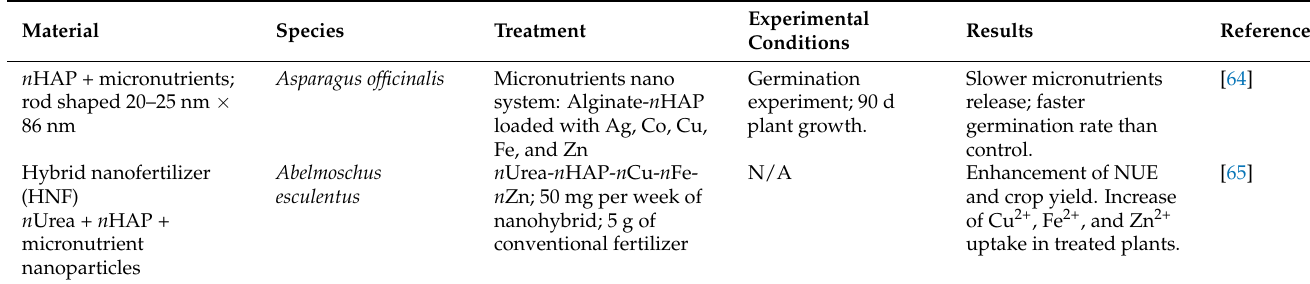
Table 3. Nano-hydroxyapatite as micronutrients